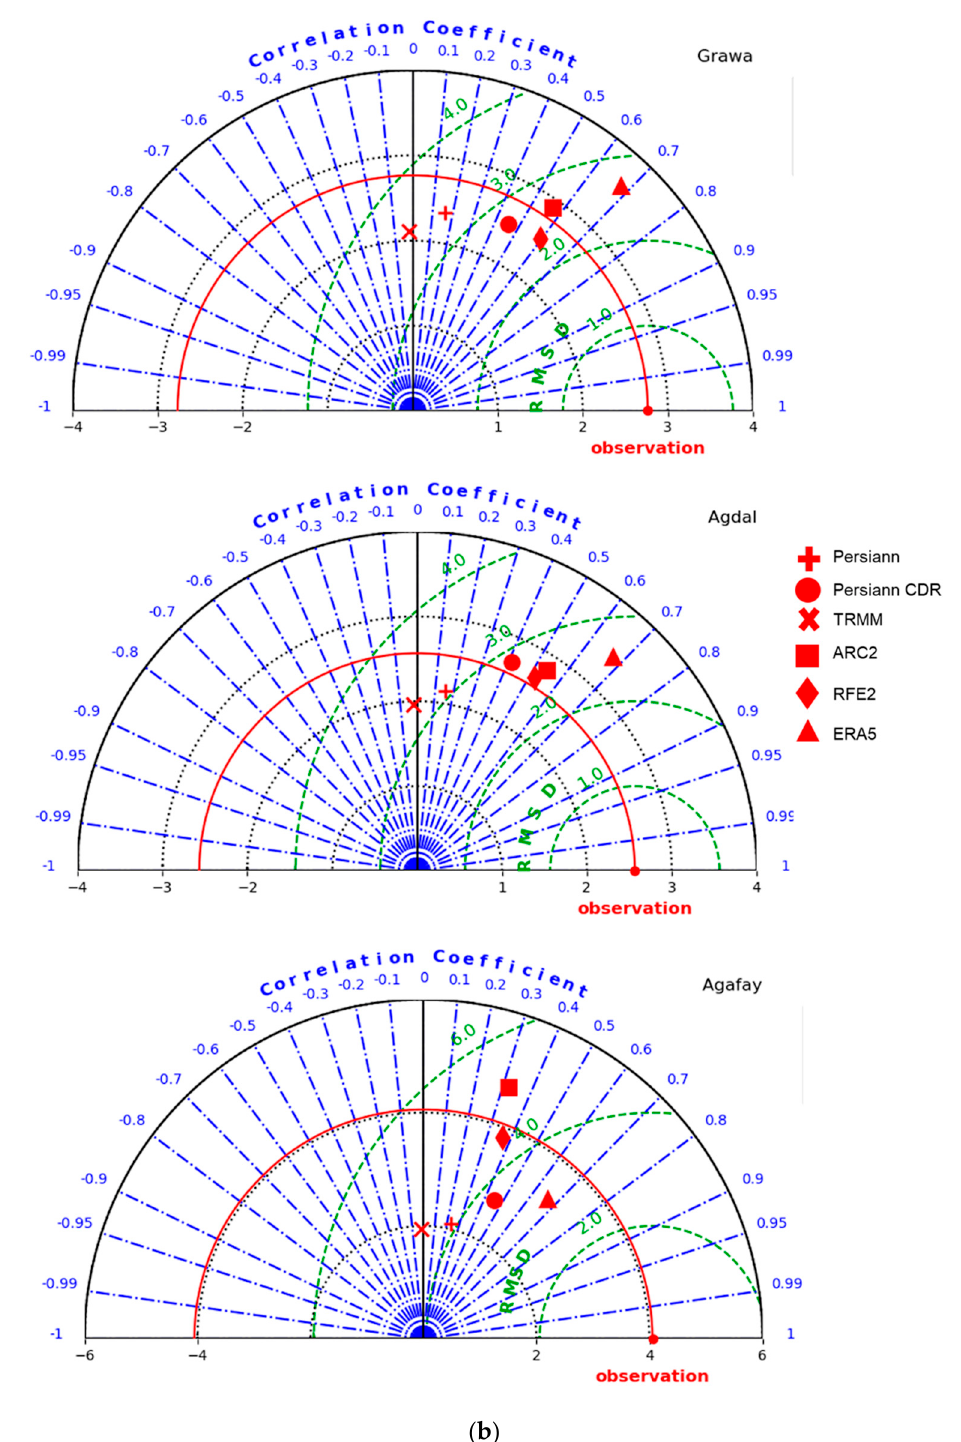
Figure 5. ( a ) Taylor diagrams of daily precipitation for Tachedert, Imskerbour, and Asni weather stations; ( b ) Taylor diagrams of daily precipitation for Grawa, Agdal, and Agafay weather stations. Asni (1170 Imskerbour (1404 m)